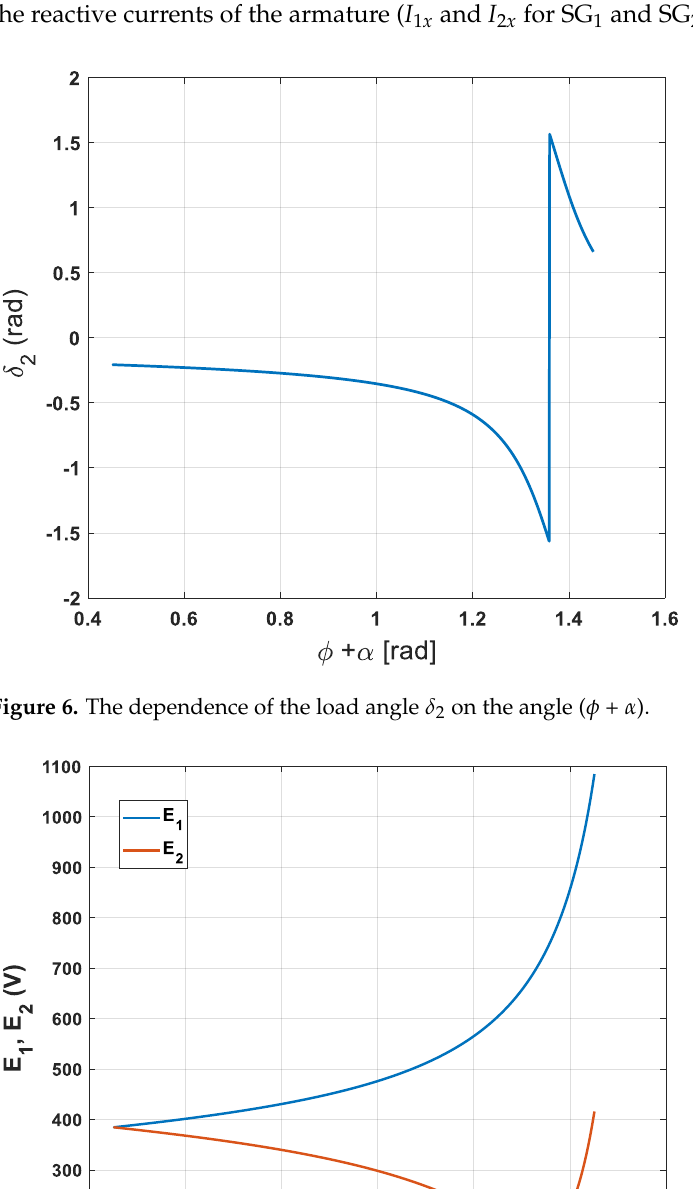
Figure 7. The dependencies of generators E 1 and E 2 on the angle ϕ + α